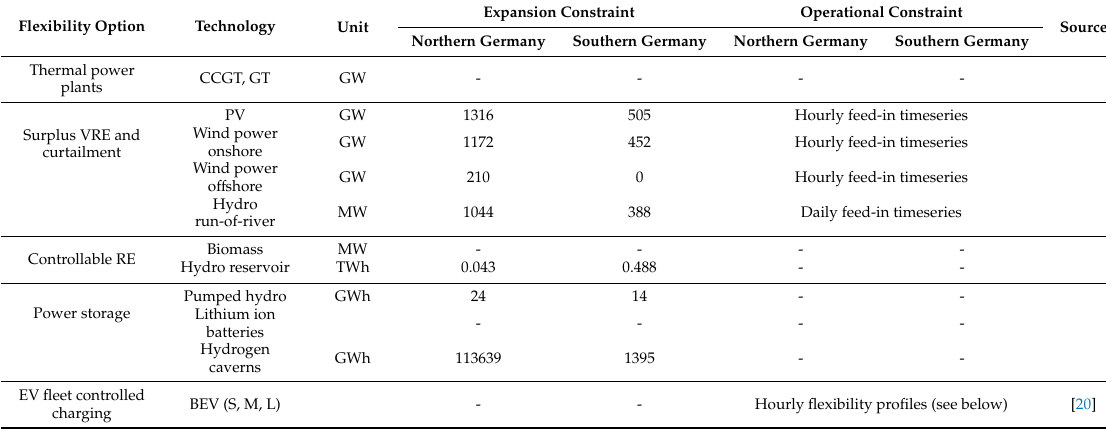
Table A3. Quantitative and qualitative flexibility options’ restrictions. Sources given in last column. Flexibility Option